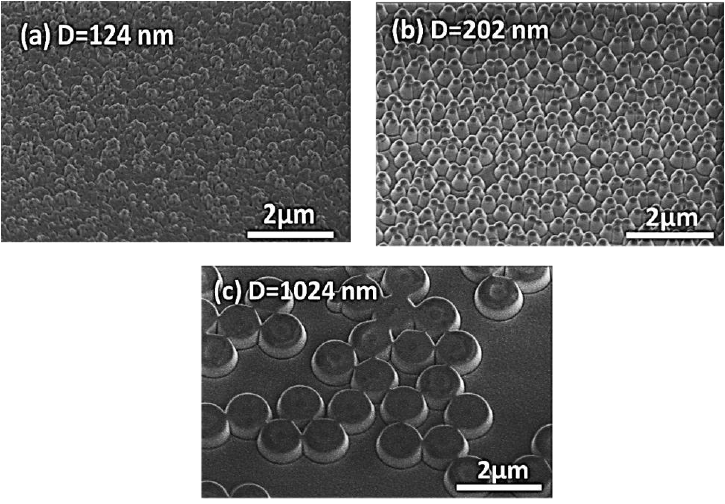
Figure 4. SEM images of disordered 2D nanostructures, tilt 30°. ( a ) D = 124 sample. ( b ) D = 202 sample. ( c ) D = 1024 sample. ( c ) D = 1024